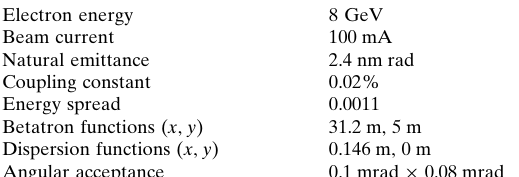
Table 2 Parameters assumed in the numerical study to evaluate the light source performance of HEU120.